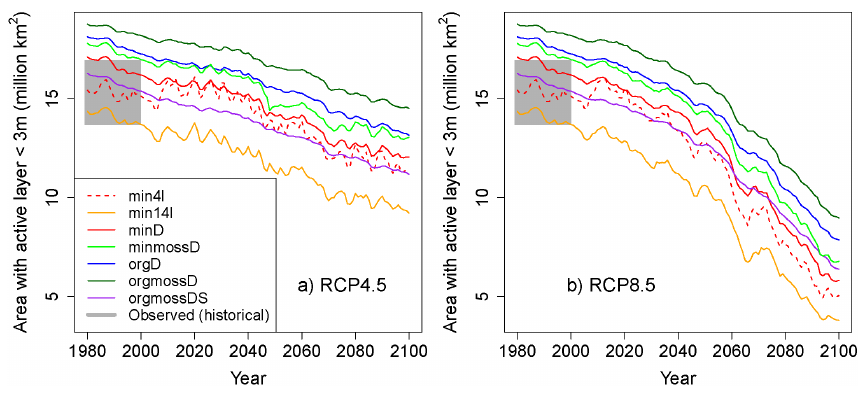
Figure 11. Time series of future projections of permafrost area. Left: RCP4.5. Right: RCP8.5. The grey area represents an estimate of the observed area from Brown et al. (1998) (see Sect. 2.4.6). Table 4. Rate of loss of near-surface permafrost per degree of high-latitude warming in future JULES simulations. The temperature change is calculated over the historical permafrost area